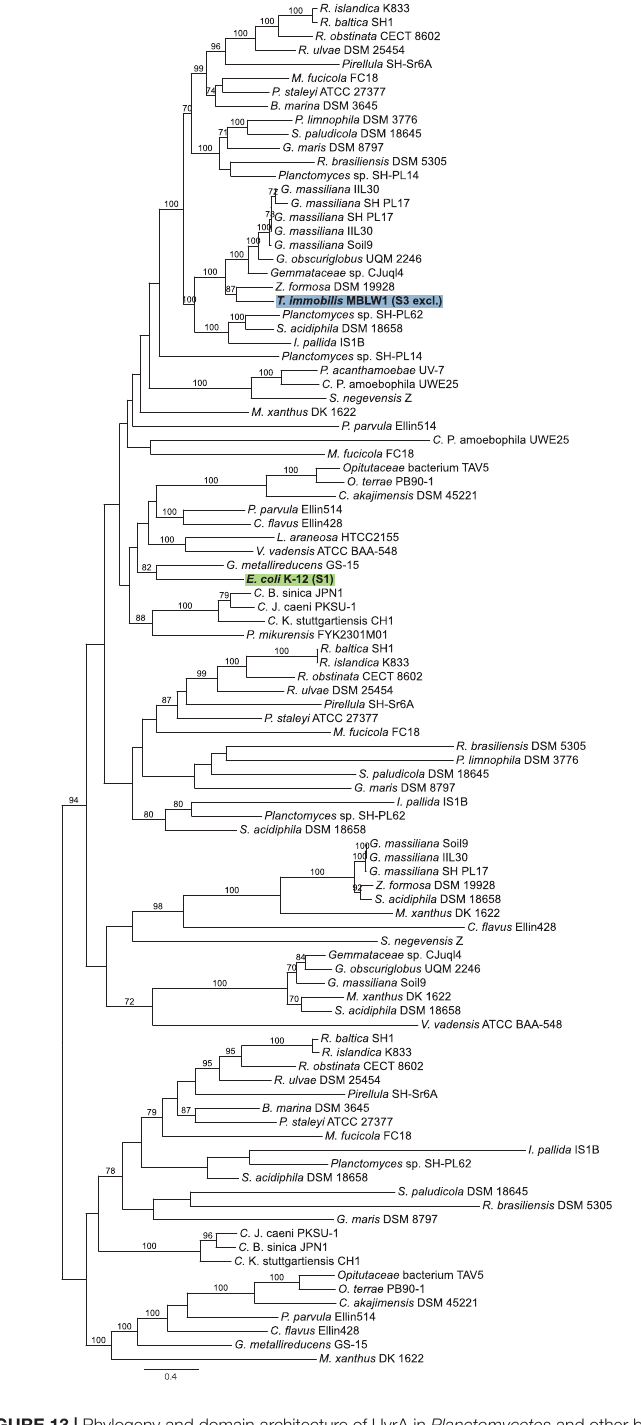
Frontiers in Microbiology |